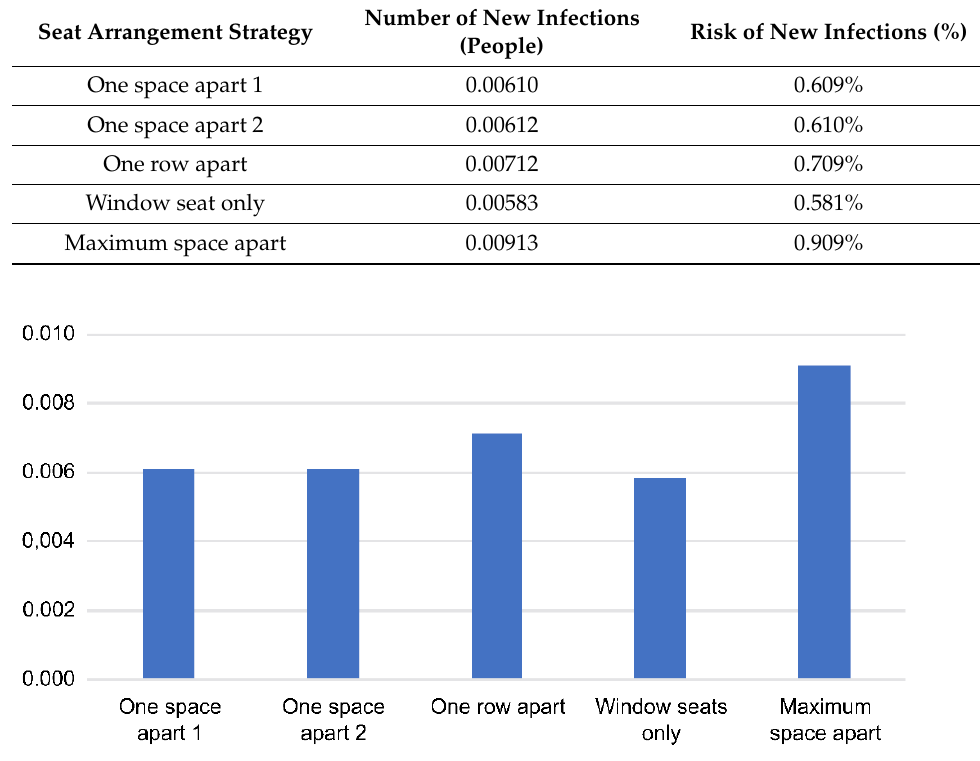
Figure 9. Number of new infections by seat arrangement strategy.